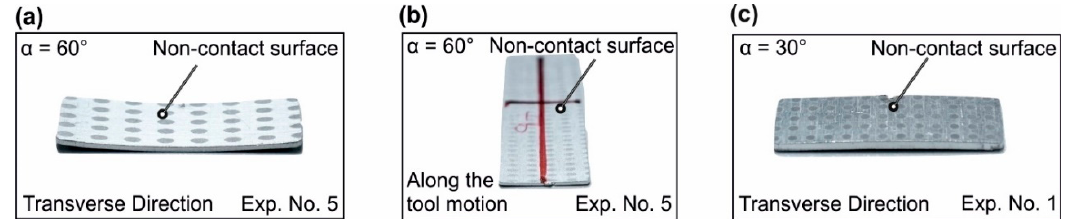
Figure 18. ( a ) Curvature of a strip for large wall angle in the transverse direction. ( b ) Curling of a strip cut along the tool motion toward the transverse direction for large wall angle. ( c ) Curvature of a strip for small wall angle in the transverse